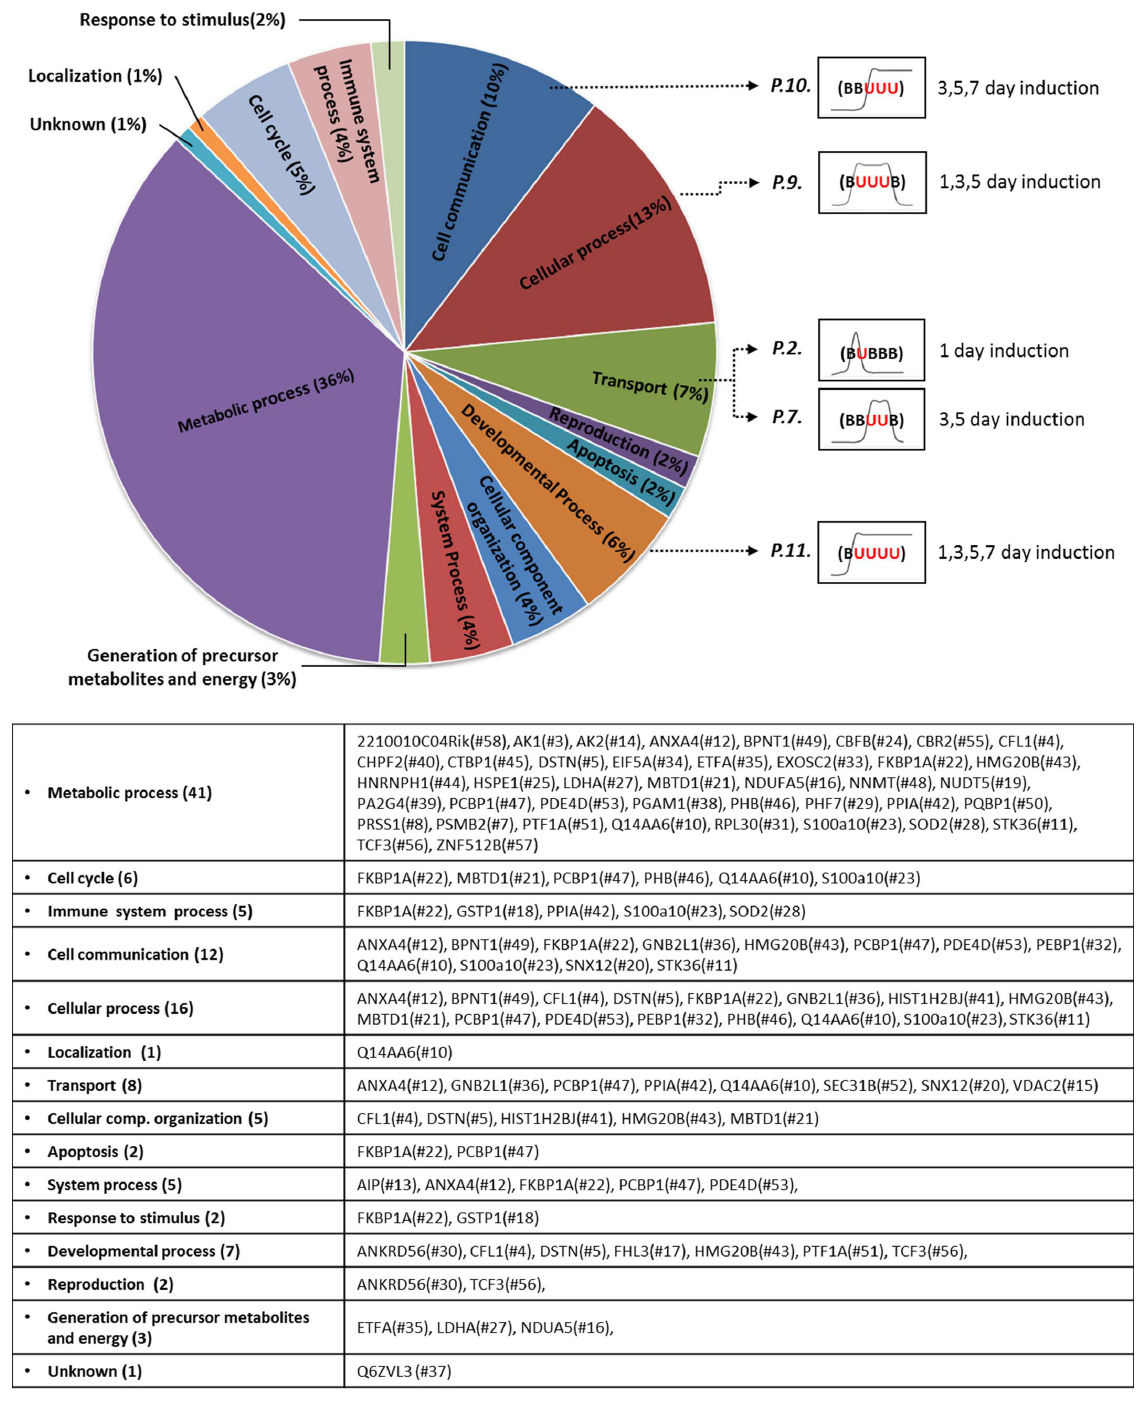
Figure 5. Functional categorization of proteins based on biological processes. Functional categories were generated based on the annotations of gene ontology using DAVID, PANTHER and the mouse genome informatics (MGI) GO_Slim Chart Tool. Four functional categories of cell communication, transport, regeneration and developmental process were exemplified with expression pattern profiles.